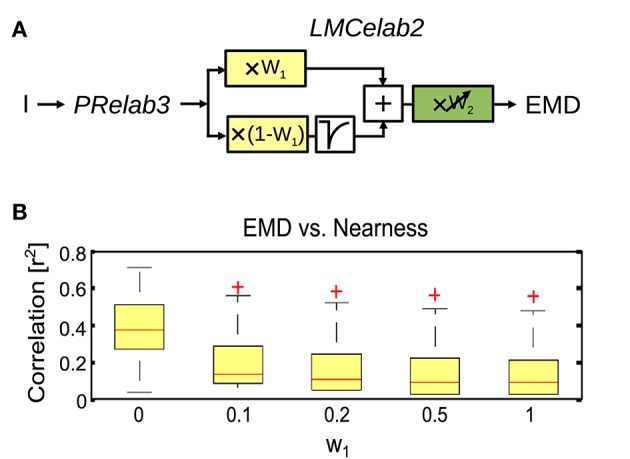
Impact of mean brightness components in the LMC response on the extraction of spatial information by EMDs. (A) Variant of visual motion pathway model PRelab3-LMCelab2-EMD (see Figure 2), in which the relative weight (w1) of the unfiltered and high-pass filtered branch of the LMC model is not adaptive, but is kept constant at different levels. (B) Correlation between EMD response profile and the nearness map for all 37 naturalistic stimuli summarized in the boxplot (red line, median; box, 25–75 percentile; red crosses, outliers), and compared between variants with different weight (w1) for the unfiltered branch, which contains the information about the mean brightness level.